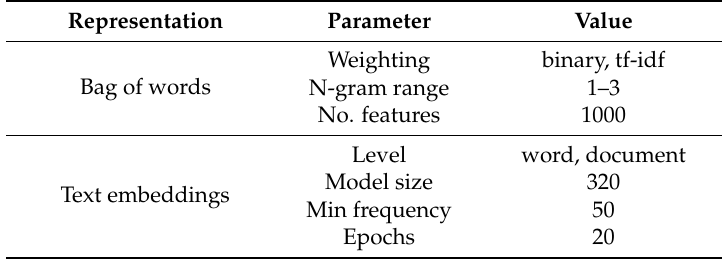
Table 2. The different types of text representations and the values of the parameters